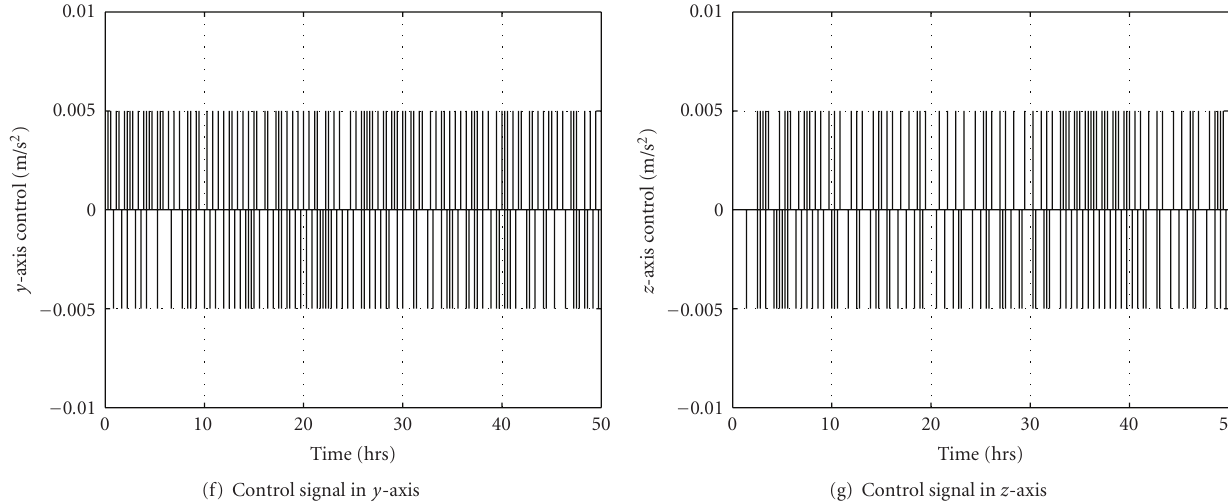
Figure 6: Simulation results using Fuzzy Logic control (control interval: 1000 seconds; maximum firing time: 2 seconds).